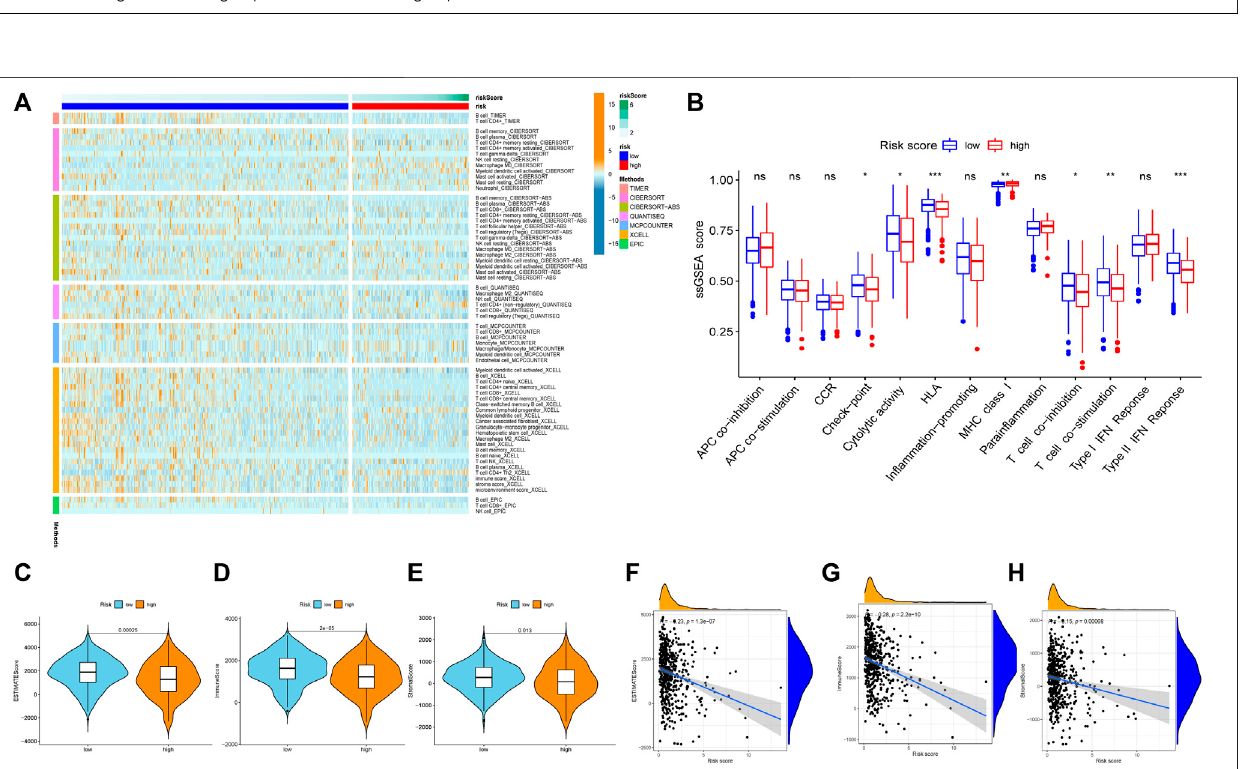
FIGURE 11 | Exploration of tumor immune microenvironment between high riskscore group and lowrisk score group. (A) Heatmap for immune responses based onCIBERSORT,TIMER,CIBERSORT-ABS,QUANTISEQ,MCPCOUNTER,XCELL,EPICalgorithmsamonghighriskscoregroupandlowriskscoregroup. (B) ssGSEA fortheassociationbetweenimmunecellsubpopulations andrelated functions. (C) ESTIMATE score. (D) Immune score. (E) Stromalscore. (F) Therelationshipbetween risk score and the ESTIMATE score. (G) The relationship between riskscore and theImmunescore. (H)The relationship between riskscore and the Stromal score. * p < 0.05; ** p < 0.01; *** p < 0.001, ns, not signi fi cant.